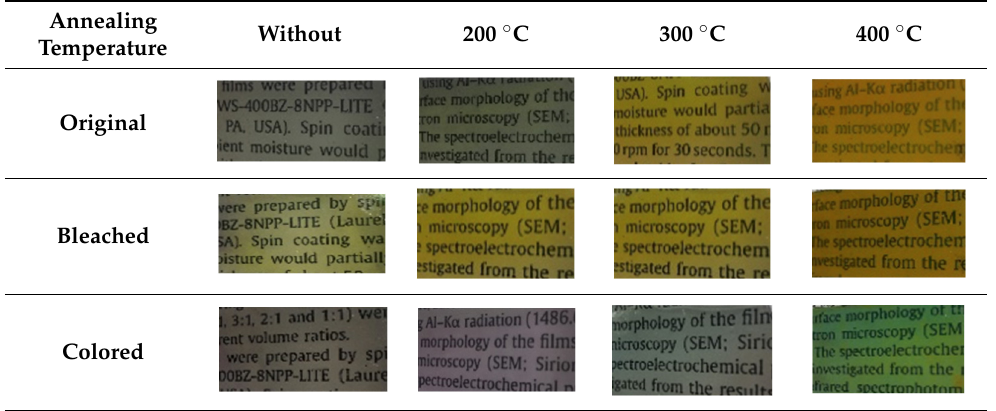
Table 2. The photographs of colored and bleached states of the V 2 O 5 thin films after various temperature annealing.